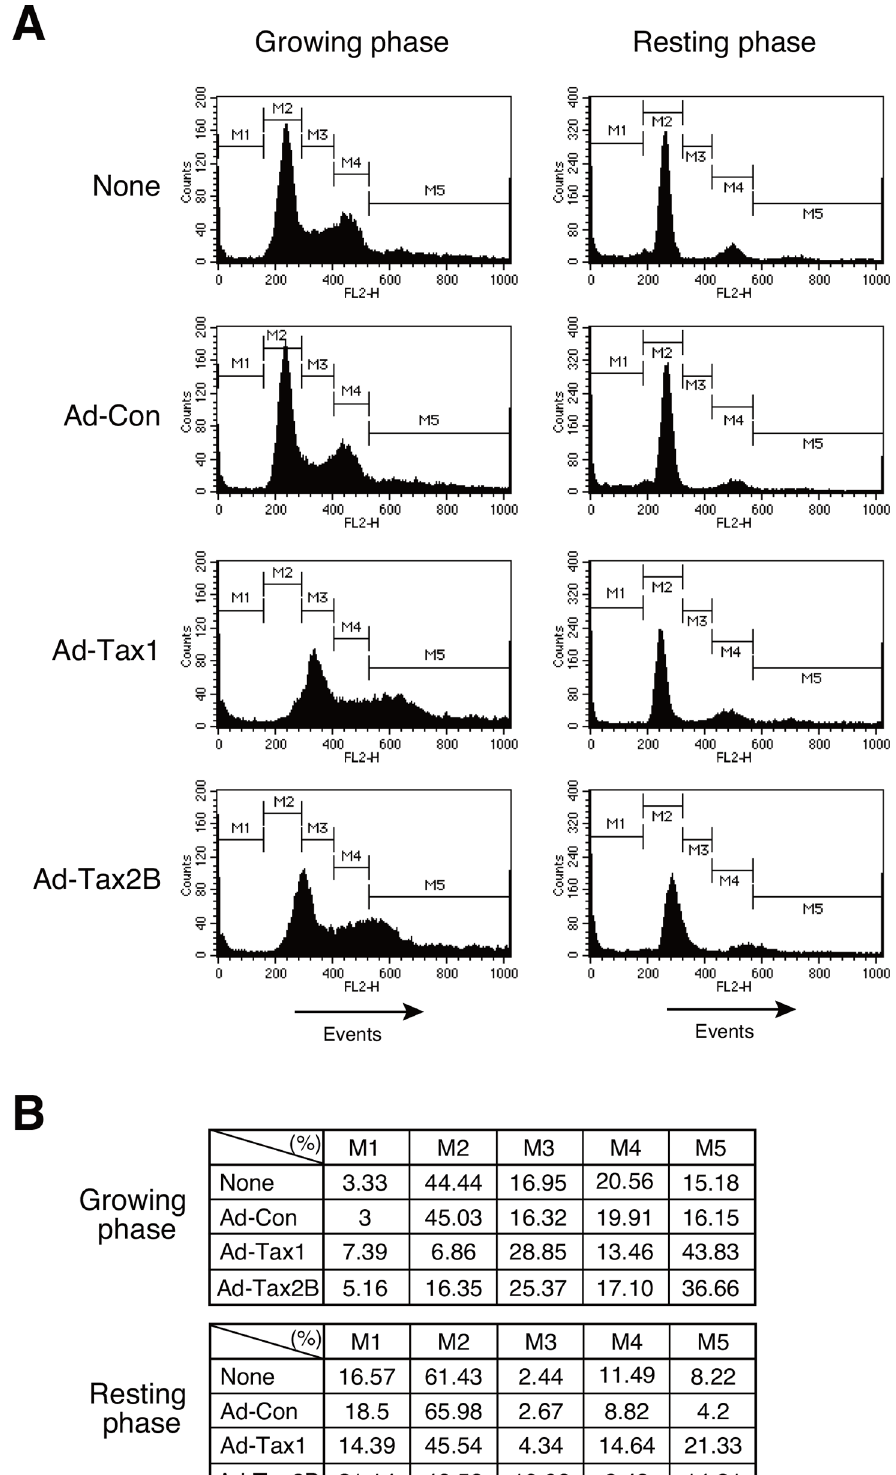
Fig 1. Cell cycle profiles of growing and resting cells with Tax1. (A) Growing or resting Kit 225 cells were infected with recombinant adenoviruses expressing Tax1 (Ad-Tax1), Tax2B (Ad-Tax2B) or control virus (Ad- Con), and cultured for 72 h. DNA content was determined using a flow cytometer after PI staining. (B)